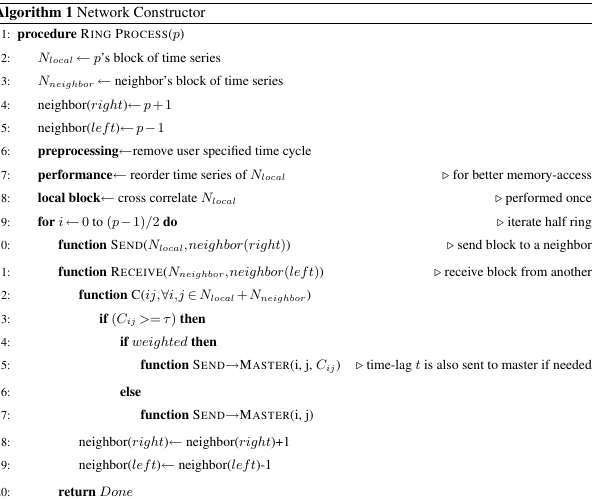
Fig.1: Provided a parallel machine of p proces- sors, p  1 processes are initialized and assigned withequal blocksof time series, each block’sset of time series are correlated, then these blocks areexchanged ( p  1) / 2 times(halfroundofthe ring)betweenprocessestocompletetheall-to-all correlationsbetweenthewholesetoftimeseries. Conversely, p 0 (themastercomputingelement)is initializedasamasterprocesstogathertheresult- ingcalculationsandperformtheanalysistaskson theresultednetwork.